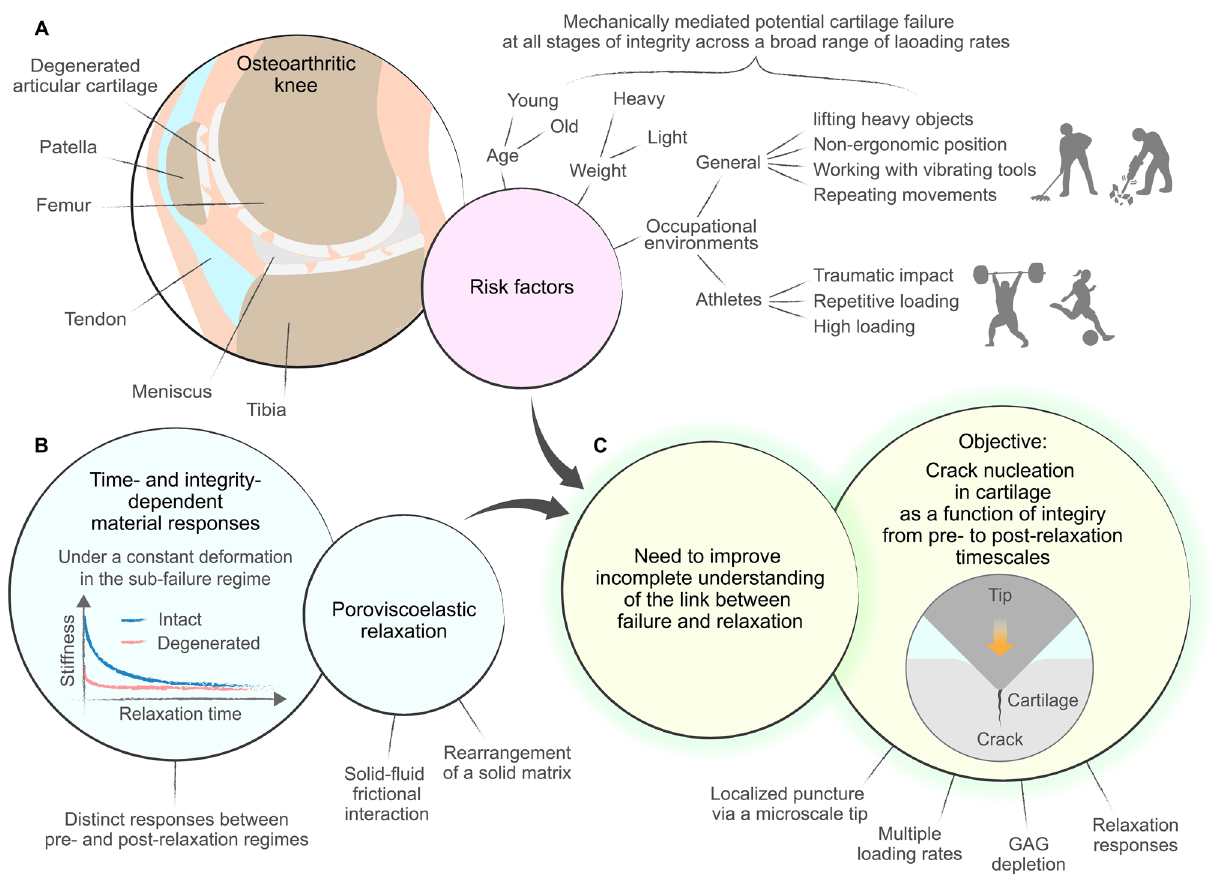
Figure 1. Schematic diagram of a strategic research plan. ( A ) Risk factors for osteoarthritis. ( B ) Time- and integrity-dependent cartilage responses observed in a sub-failure regime. ( C ) Objective of the current